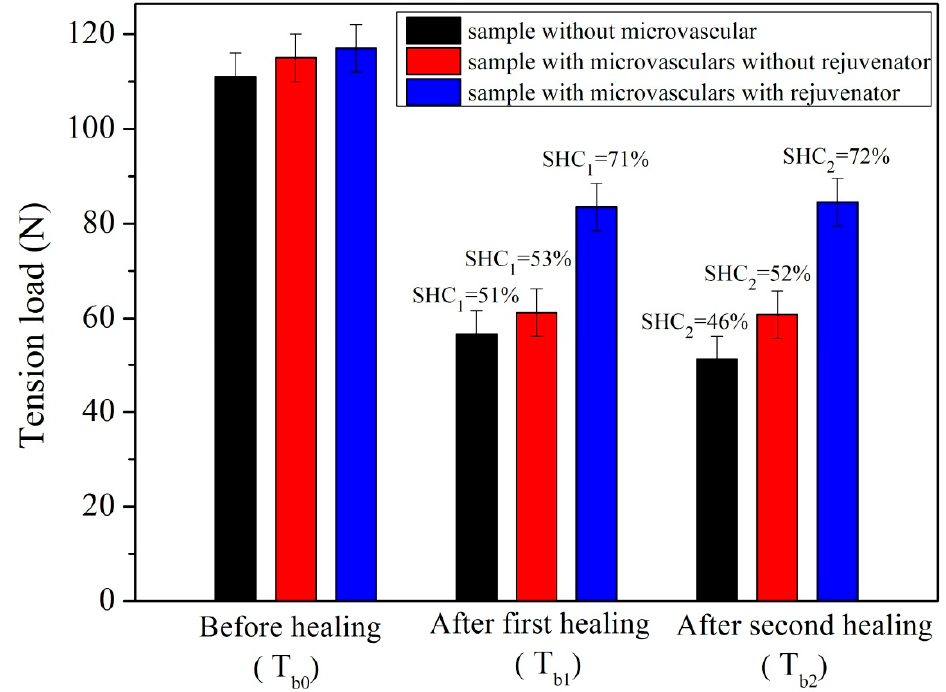
Figure 9. Tension load values and self-healing capability (SHC 1 and SHC 2 ) values of three asphalt samples (one sample without microvascular, one sample with microvascular without rejuvenator, and one sample with microvascular containing rejuvenator) under 0 °C during two self-healing cycles, each self-healing cycle carried out for 24 h.